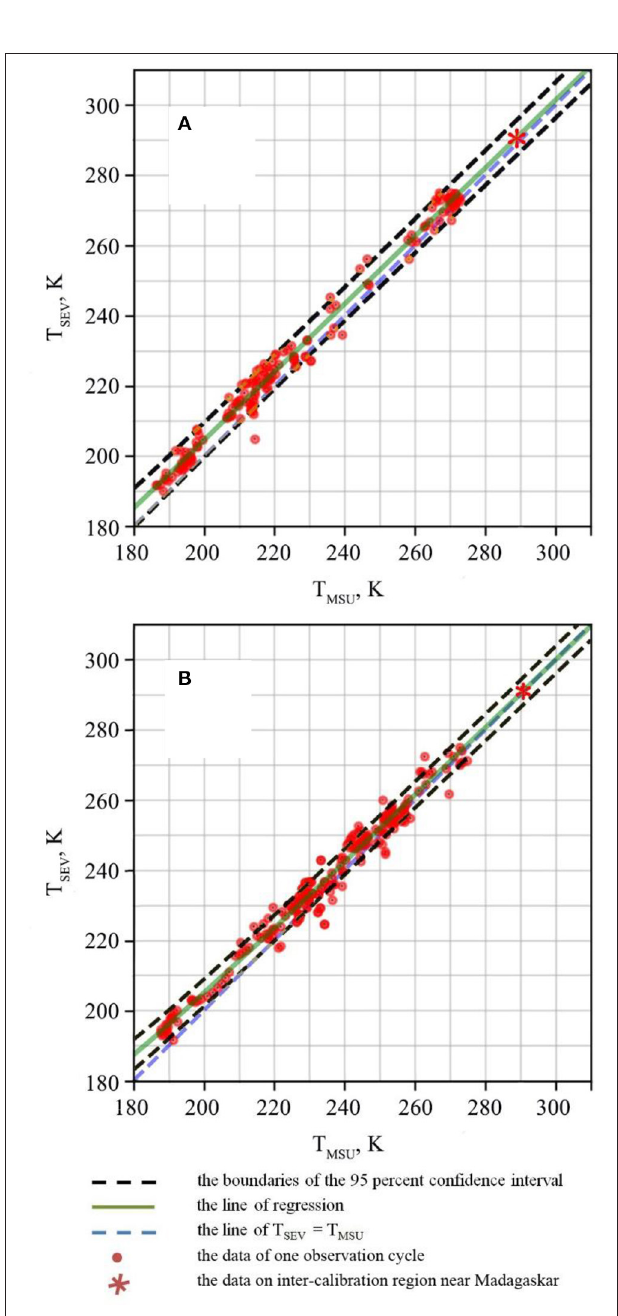
FIGURE 2 | Examples of regressions TSEV (TMSU), 2018: (A) -April 27, 14:00 UTC; (B) -May 7, 14:30